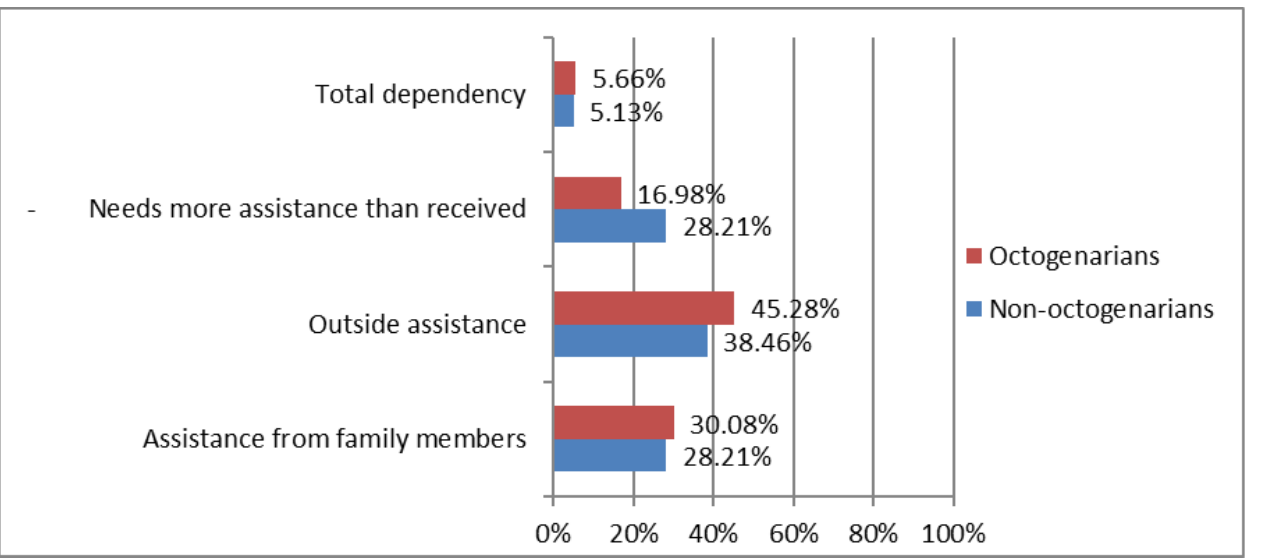
Figure 4. Differences between octogenarians vs. non-octogenarians in in assistance needs during COVID-19 confinement. Octogenarians (≥80 years; n = 53). Non-octogenarians (<80 years; n = 67).